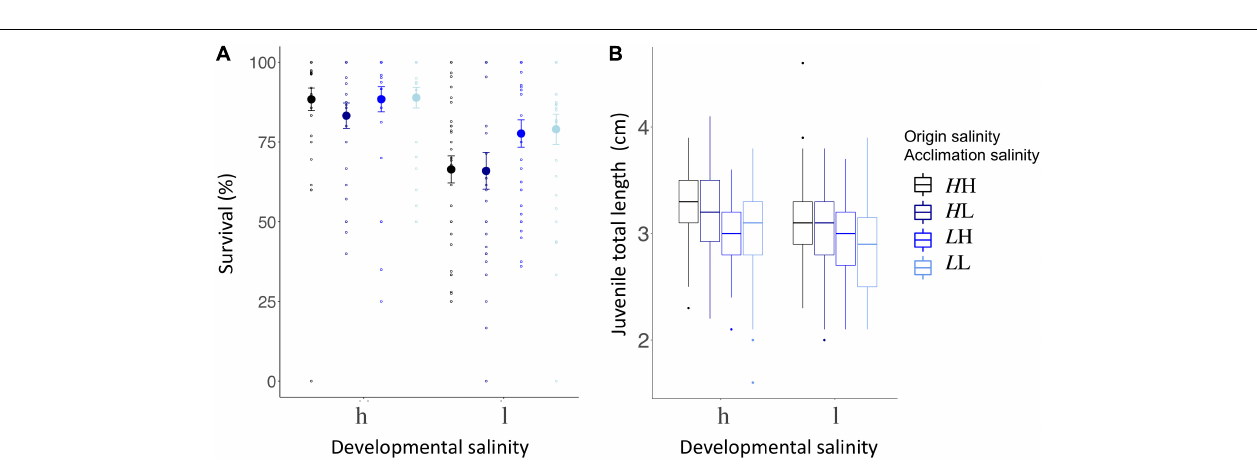
FIGURE 5 | Parental life-history traits. (A) Number of juveniles (brood size) is shown for pipefish with high ( H ) or low ( L ) origin salinity . Color indicates acclimation salinity in the lab (H: 15 PSU – dark blue and L: 7 PSU – light blue). Different letters indicate significant differences (Tukey’s HSD, p < 0.05). (B) Brood size correlated positively with the average size of male pipefish from each sampling site. The sampling sites are presented above the data points. The gray bar along the regression line indicates the 95% confidence interval. A more detailed figure visualizing the differences between the single origins can be found in the Supplementary Table 7C .